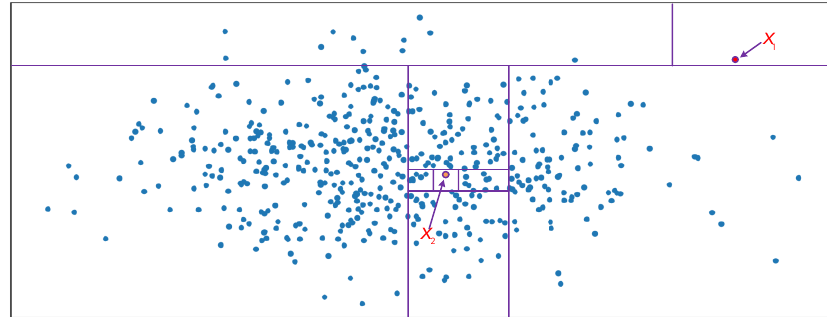
Figure 3. Division of sample points.